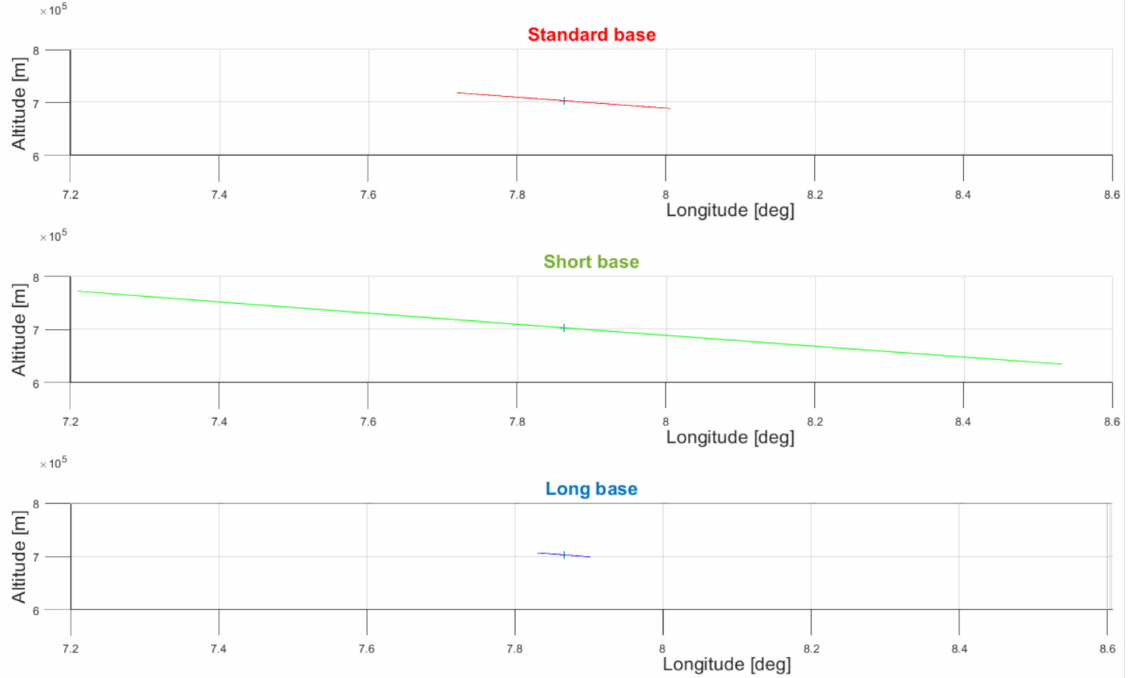
Figure 15. Sections of error ellipsoids in longitude to altitude plane